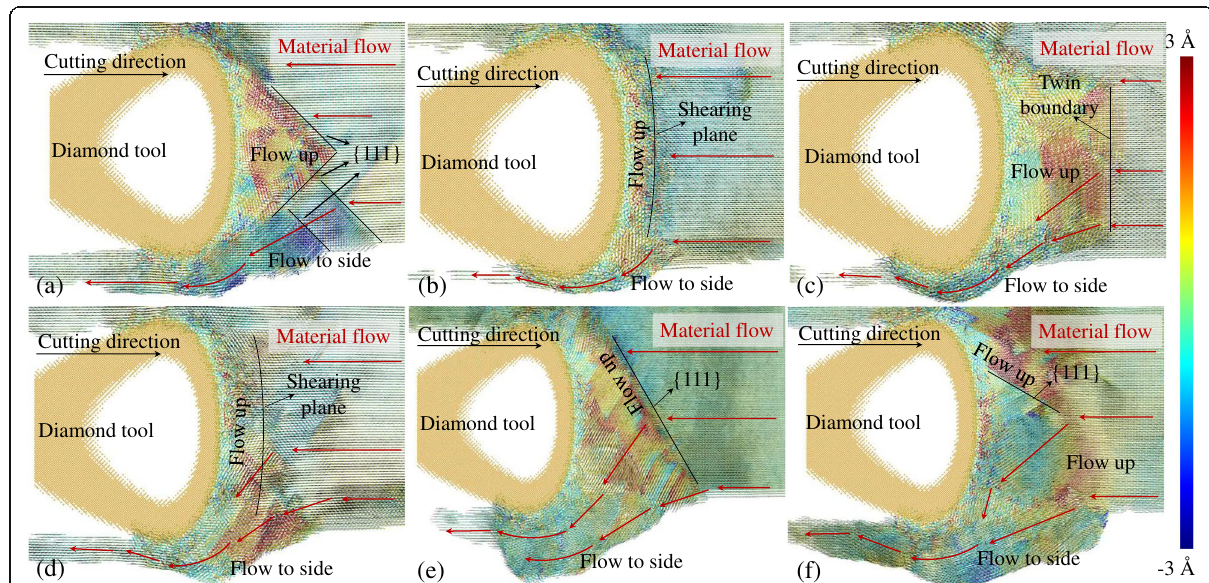
Fig. 7 Displacement vector plots in cutting direction of ( a ) {100} < 001>, ( b ) {100} < 011>, ( c ) {110} < 001>, ( d ) {110} < 1 – 10>, ( e ) {111} < 1 – 10